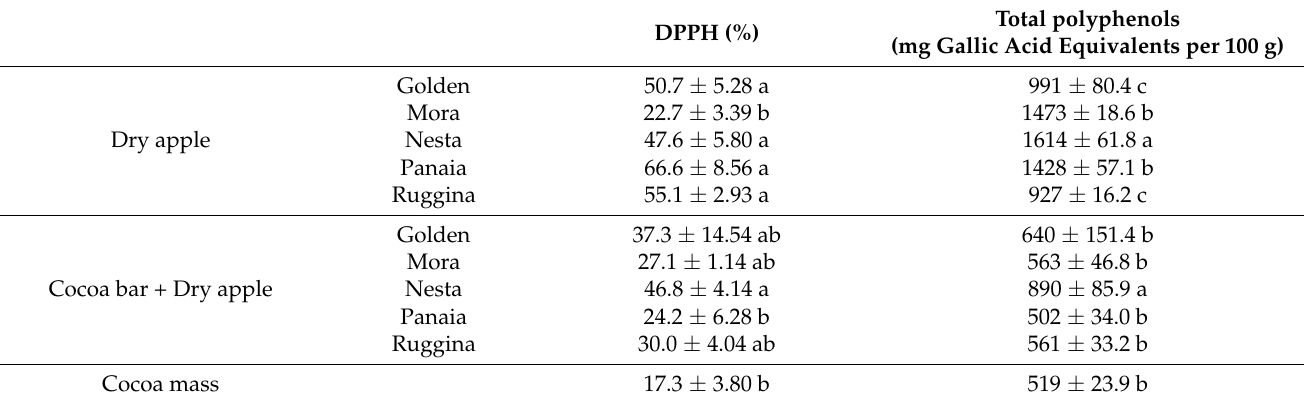
Table 2. Total antioxidant capacity (DPPH%) and total polyphenols concentration (mg gallic acid equivalents per 100 g of DW or FW) in dry apples, in the cocoa bar with dry apples, and in the cocoa mass. Data ( n = 3) were analyzed by one-way ANOVA. Different letters are significantly different according to Tukey’s post-hoc test at the 0.05 probability level. Total polyphenols DPPH (%) (mg Gallic Acid Equivalents per 100 g) Golden 50.7 ± 5.28 a